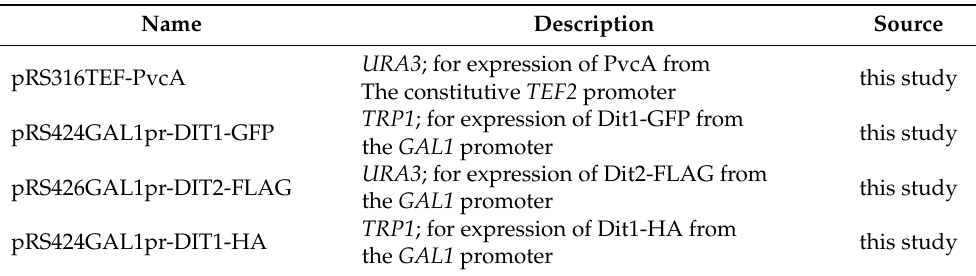
Table 3. Plasmids used in this